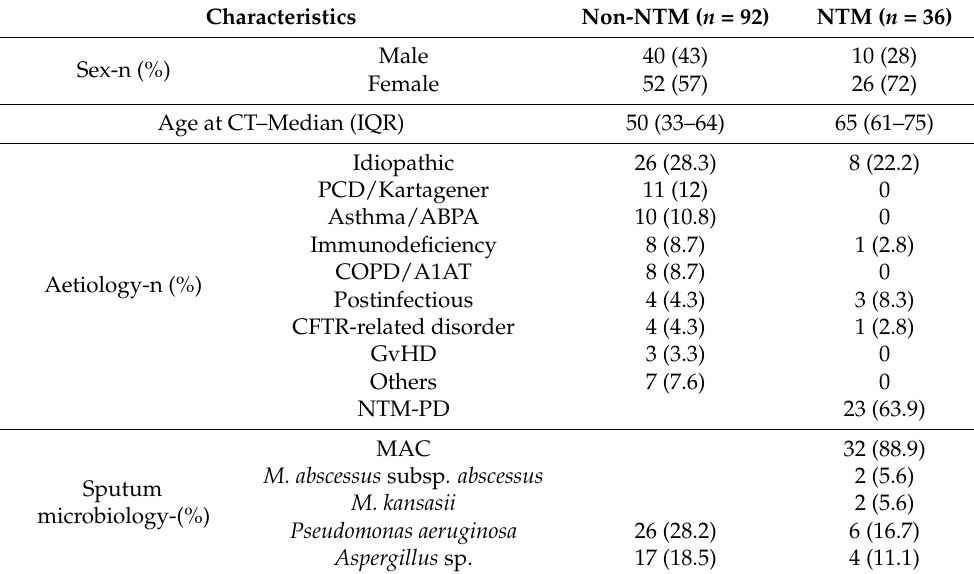
Table 1. Characteristics for patients with and without